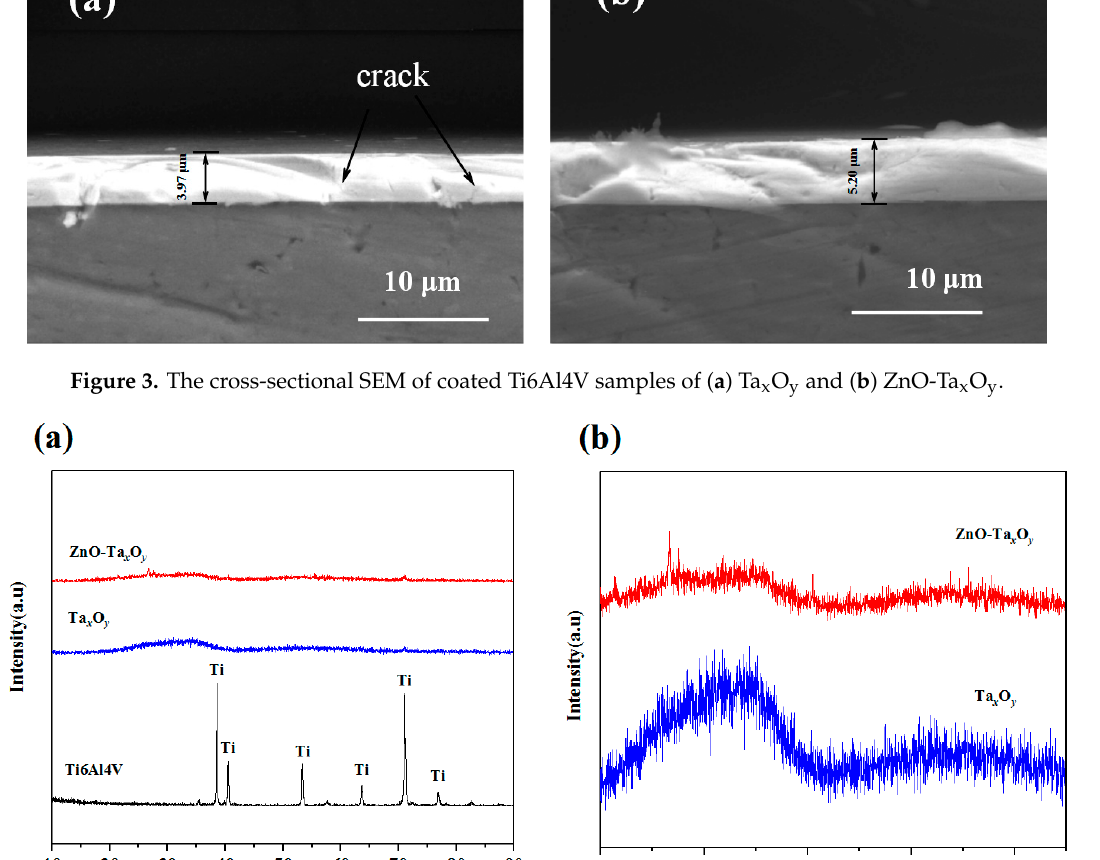
Figure 4. XRD patterns of samples (a) and coated Ti6Al4V (b).